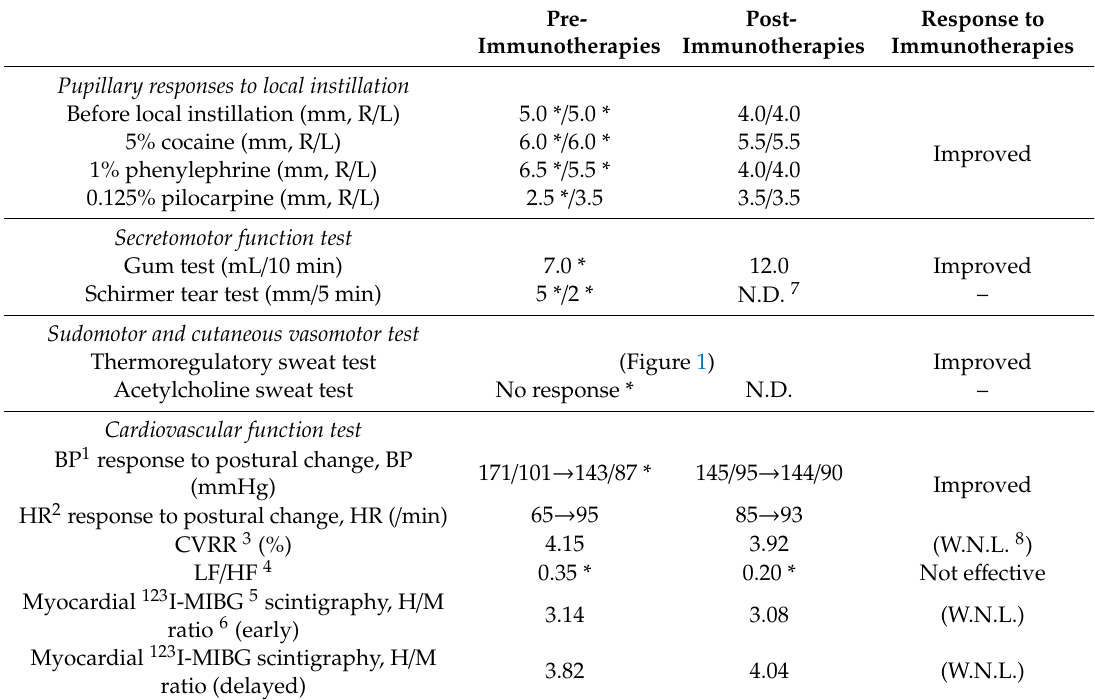
Table 1. Autonomic function tests in Patient 1.